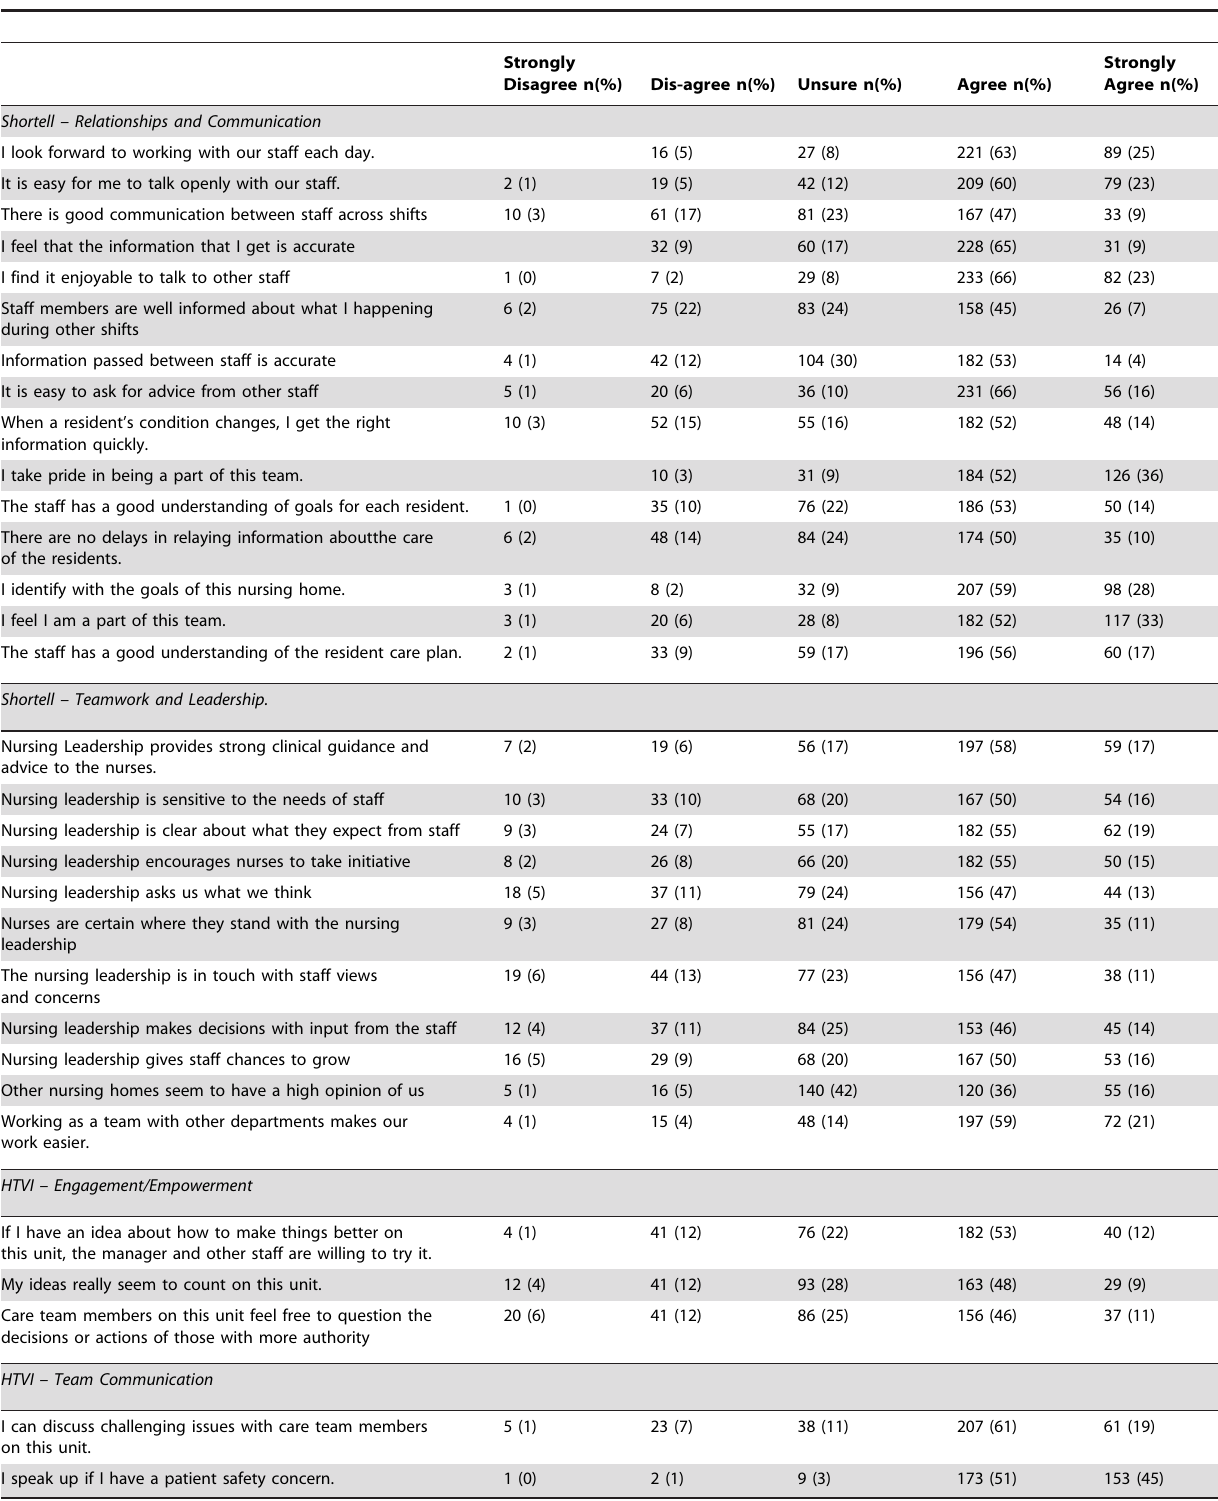
Table 1. Staff responses to individual survey items [n (%)].